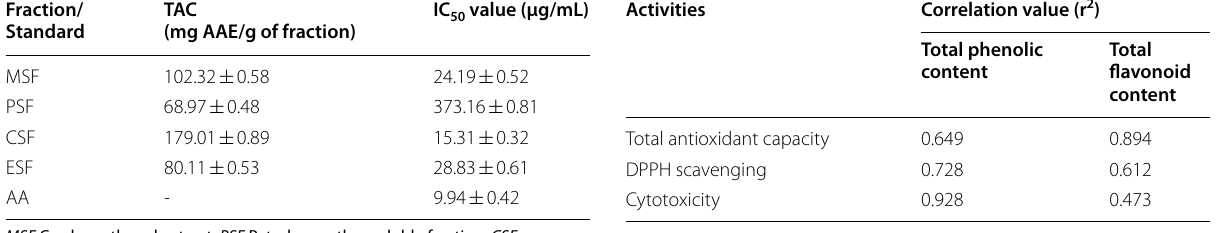
SD ( n 3). PSF, Petroleum ether soluble fraction; ± =